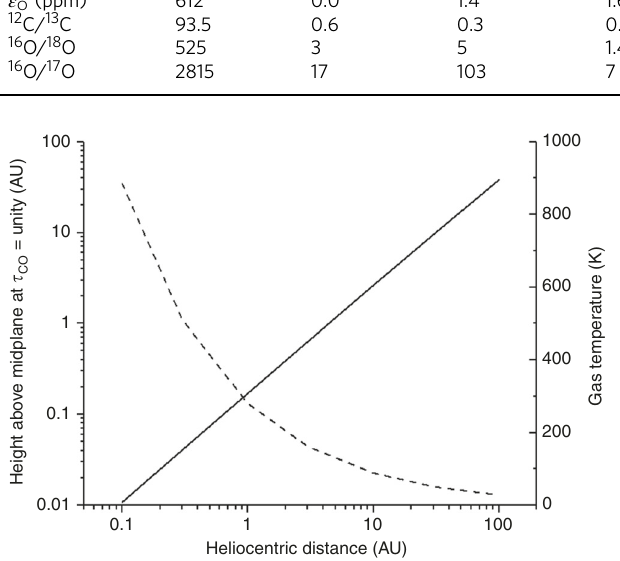
Table 1 Mean and 1-sigma errors contributions for O abundance and isotope ratios in the Sun Ratio